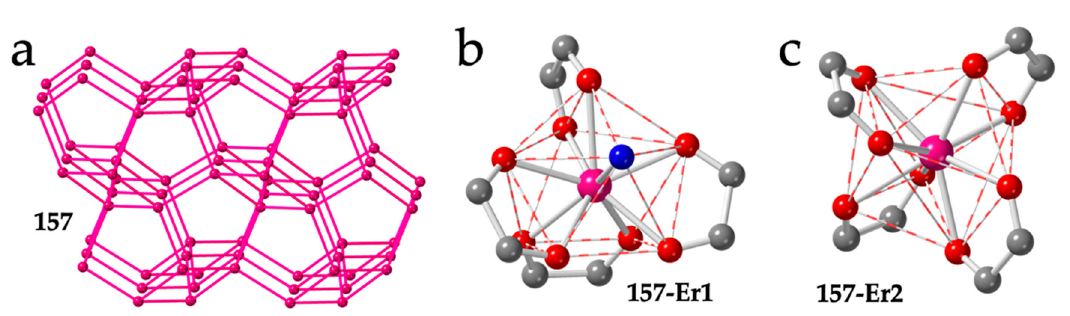
Figure 21. ( a ) View of the structure of compound 157 . Only the Er(III) ions are shown. Pink lines connecting the Er atoms represent the anilato bridges. ( b ) Coordination environment of the Er1 ion in compound 157 . ( c ) Coordination environment of the Er2 ion in compound 157 . Colour code: Ln = pink, C = grey, O anilato = red and O water = blue.